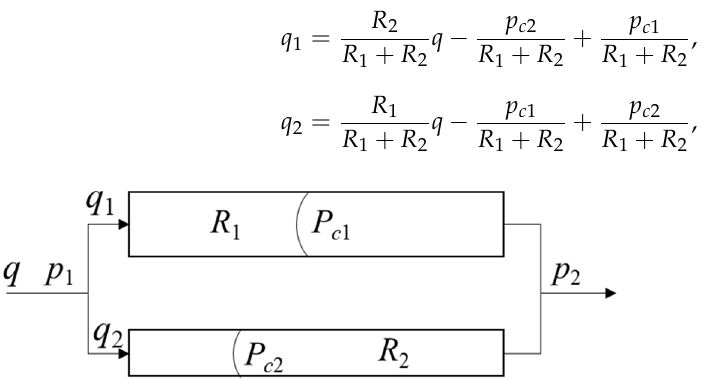
Figure 11. Schematic diagram of the parallel channels.